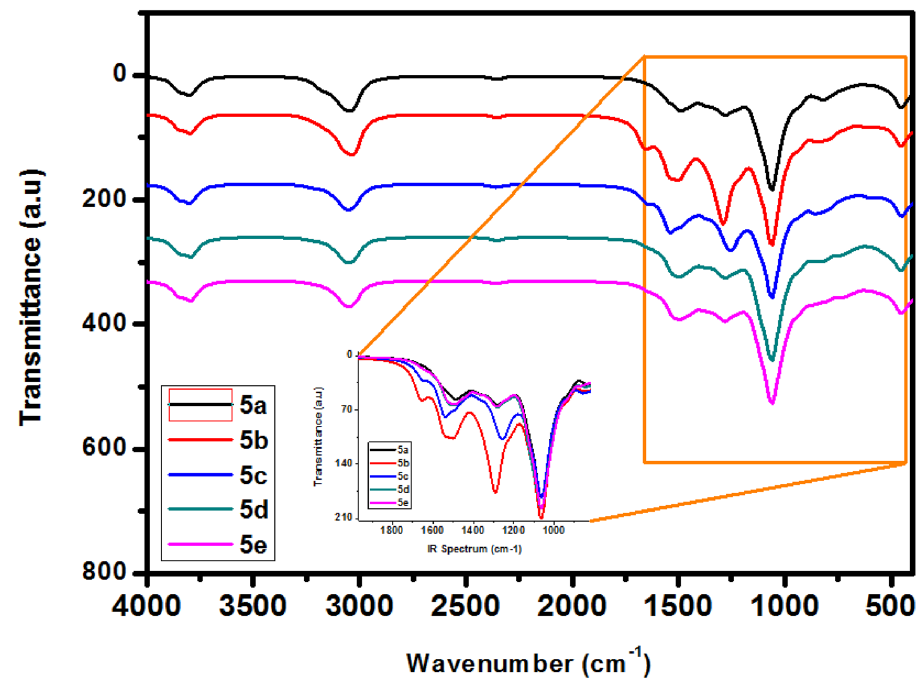
Figure 6. FTIR spectra of the pyrazolylnucleosides 5a – e